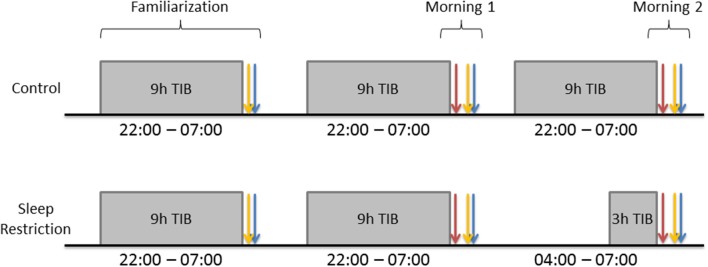
Gray rectangles represent participant sleep opportunities. Blue arrows represent Profile of Mood States (POMS) completion. Yellow arrows represent Stanford Sleepiness Scale (SSS) completion. Red arrows represent Dalhousie Computerized Attention Battery (DalCAB) completion. DalCAB was always started within 1 h of waking in the mornings.